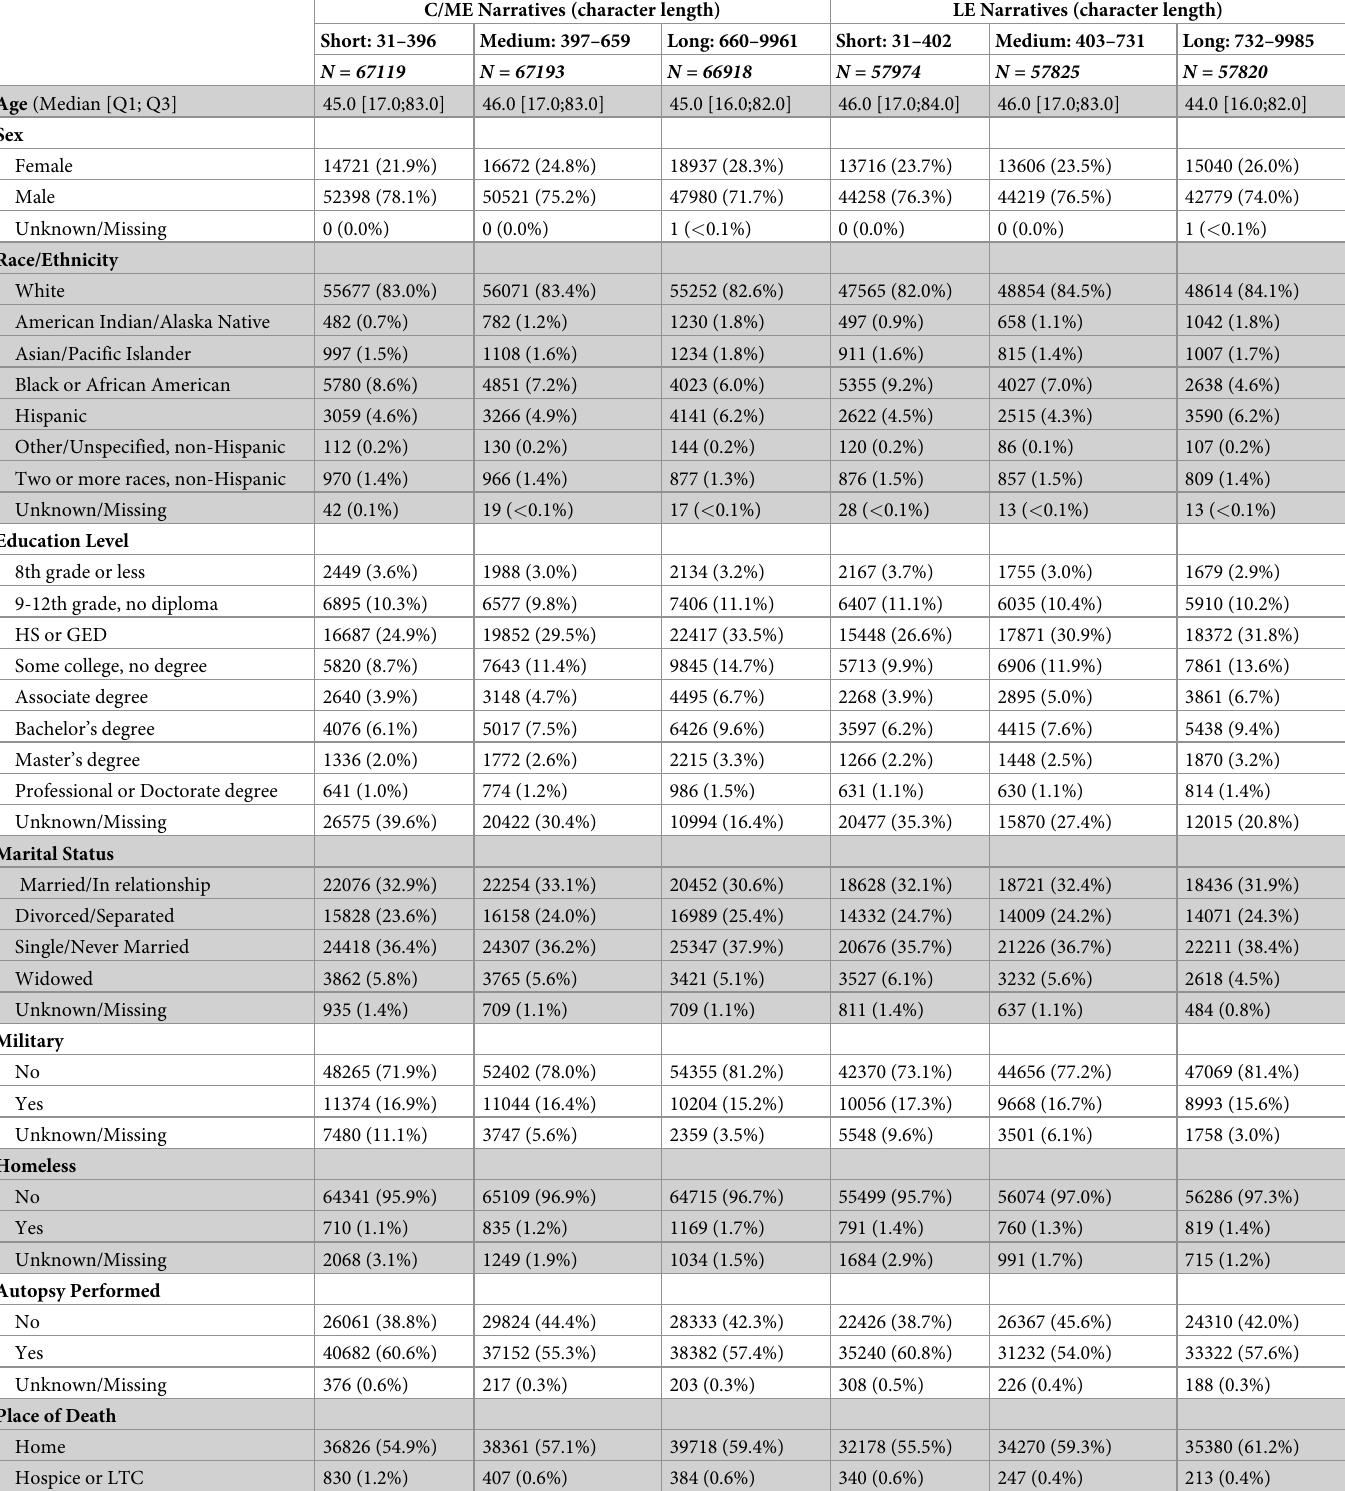
Table 2. Decedent characteristics stratified by narrative length: Suicide and undetermined deaths in the National Violent Death Reporting System,